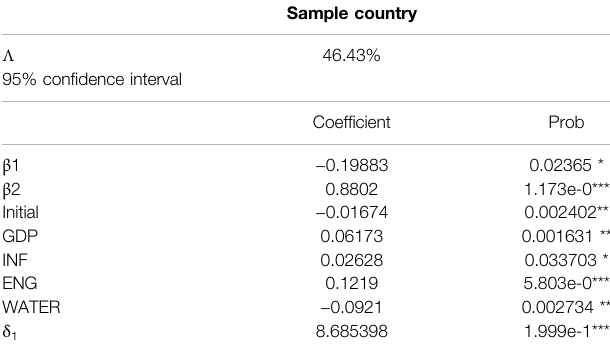
TABLE 5 | Dynamic panel threshold